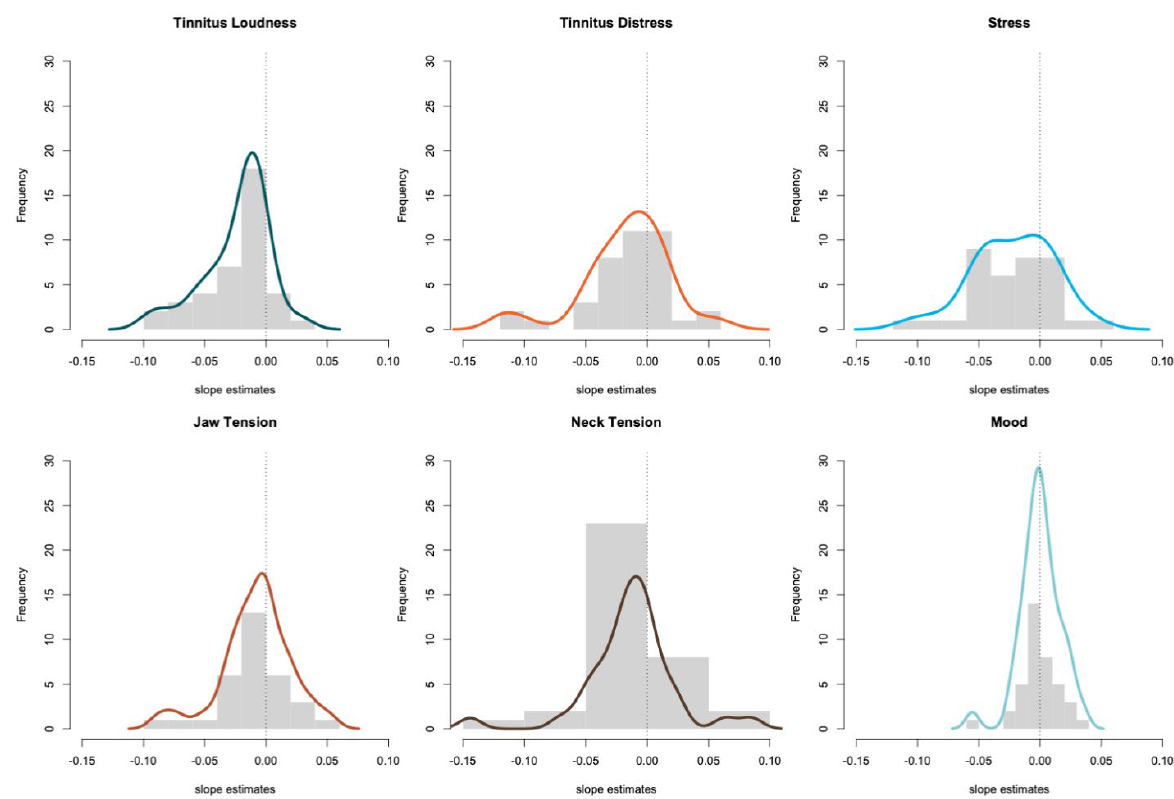
Figure 2. Visualization of the slope estimates in the linear regression models. A histogram of the slope estimates is shown for tinnitus loudness, tinnitus distress, stress, jaw tension, neck tension and mood. Density plots overlay the histograms.